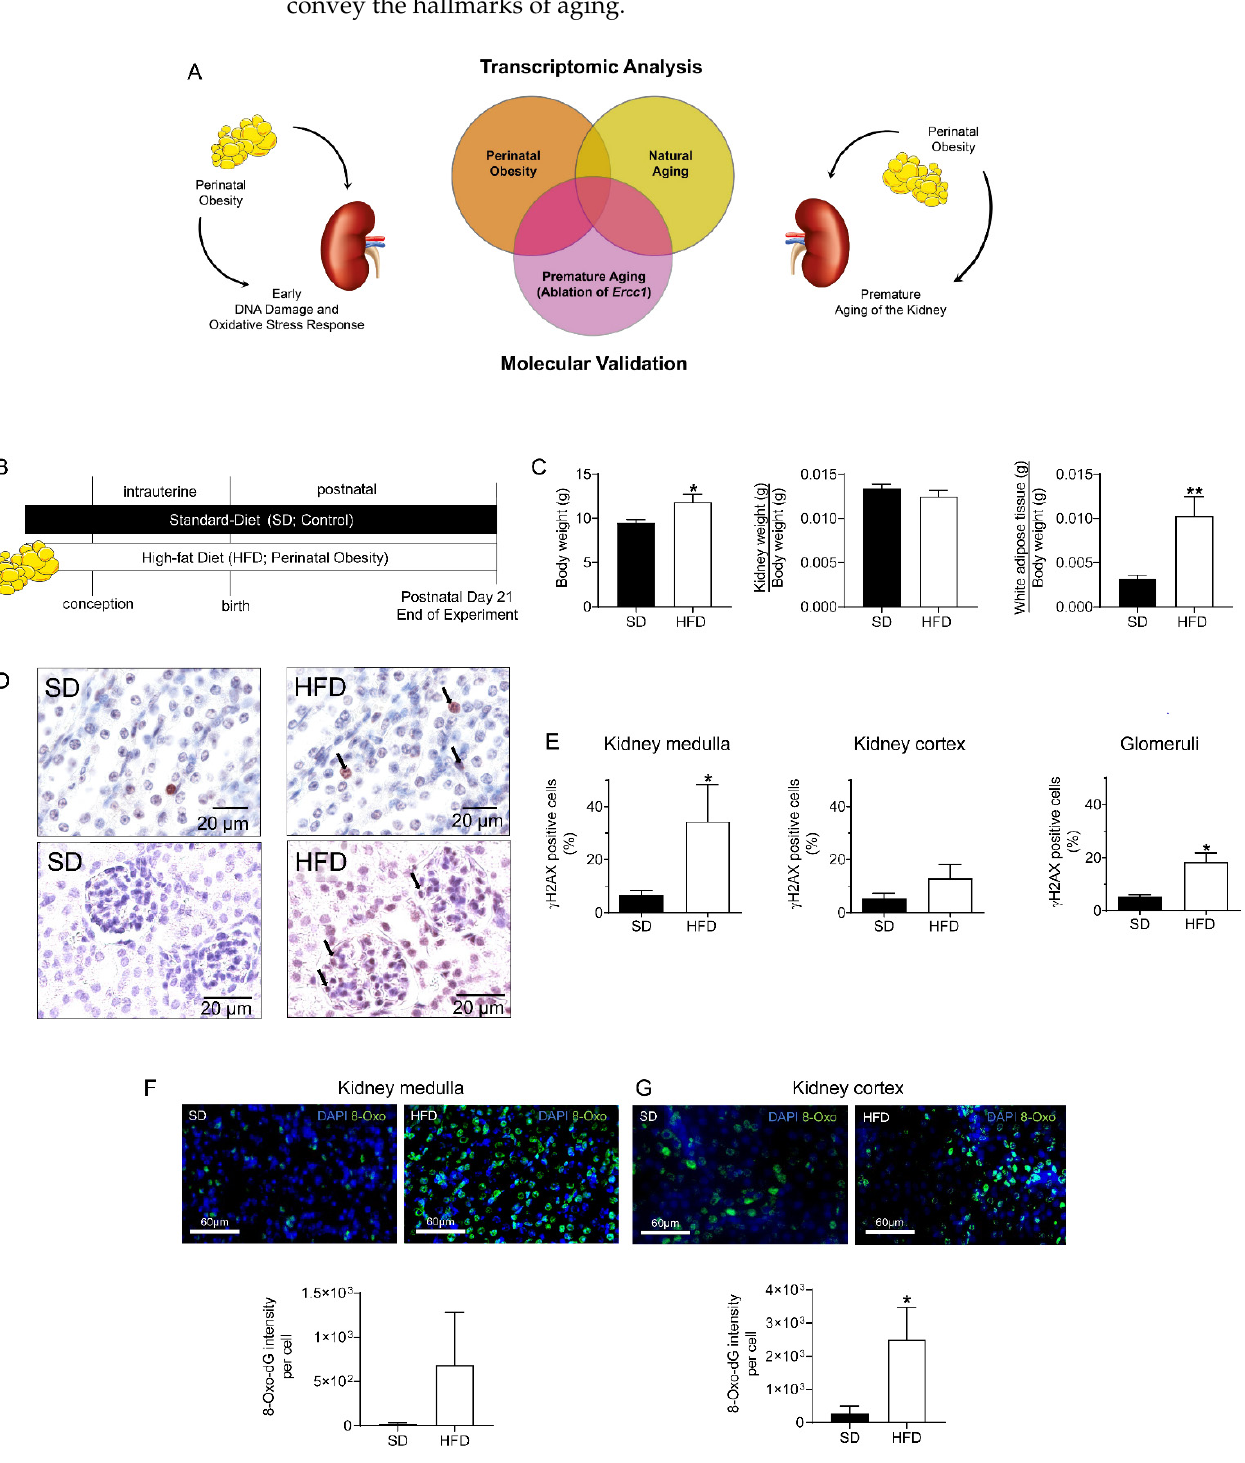
Figure 1. ( A ): Study design: Perinatal obesity induces aging-associated processes, e.g., DNA damage response, and causes premature aging of the kidneys with increased susceptibility for chronic kidney diseases later in life. Identification of converging signaling pathways using transcriptomics of kidneys from male offspring at postnatal day 21 (P21) after perinatal obesity, naturally-aged kidneys and prematurely-aged kidneys of genetic modified mice with an ablation or Ercc1 . ( B ): Scheme illustrating the experimental mouse model of perinatal obesity, in which male offspring of high-fat diet (HFD, perinatal obesity) or standard diet (SD, control) fed dams are investigated at P21. ( C ): Body weight (g), kidney weight (g) to body weight (g) ratio, and white adipose tissue (g) to body weight (g) ratio in male offspring at P21. ( D , E ): Assessment of DNA damage response (DDR) using γ H2AX as an indicator in kidneys at P21. Representative immunohistochemical